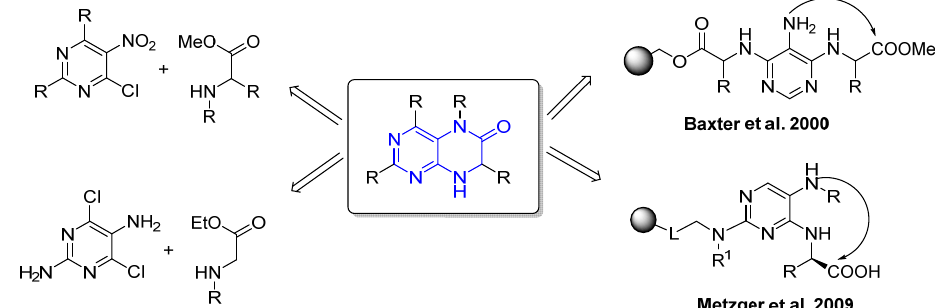
Figure 2. Overview of known methodologies.